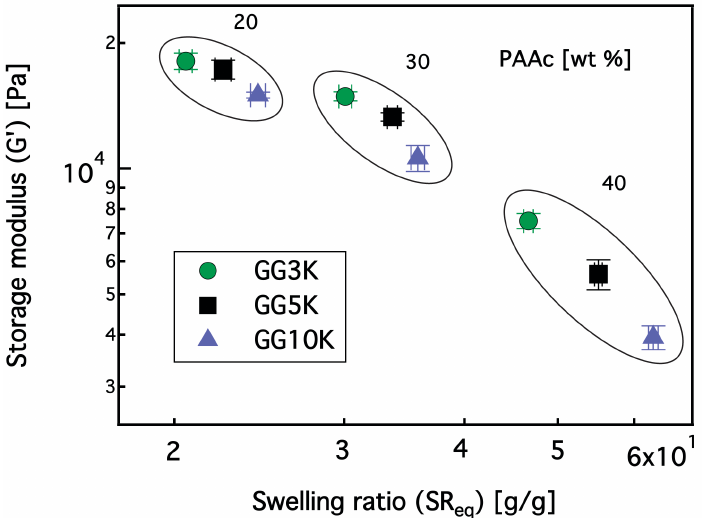
Figure 6. Storage modulus ( G (cid:48) ) as a function of the equilibrium swelling ratio of gels with different fraction of PAAc and different comb-chain